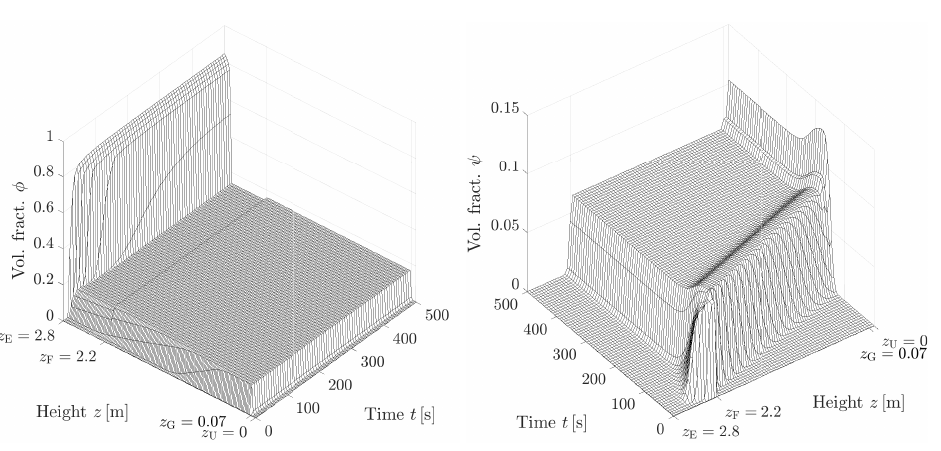
Figure 14. Dynamic simulation of bubble–solids–liquid flow. Time evolution from t = 0s to t = 500s of the volume fraction profiles of bubbles φ ( left ) and solids ψ ( right